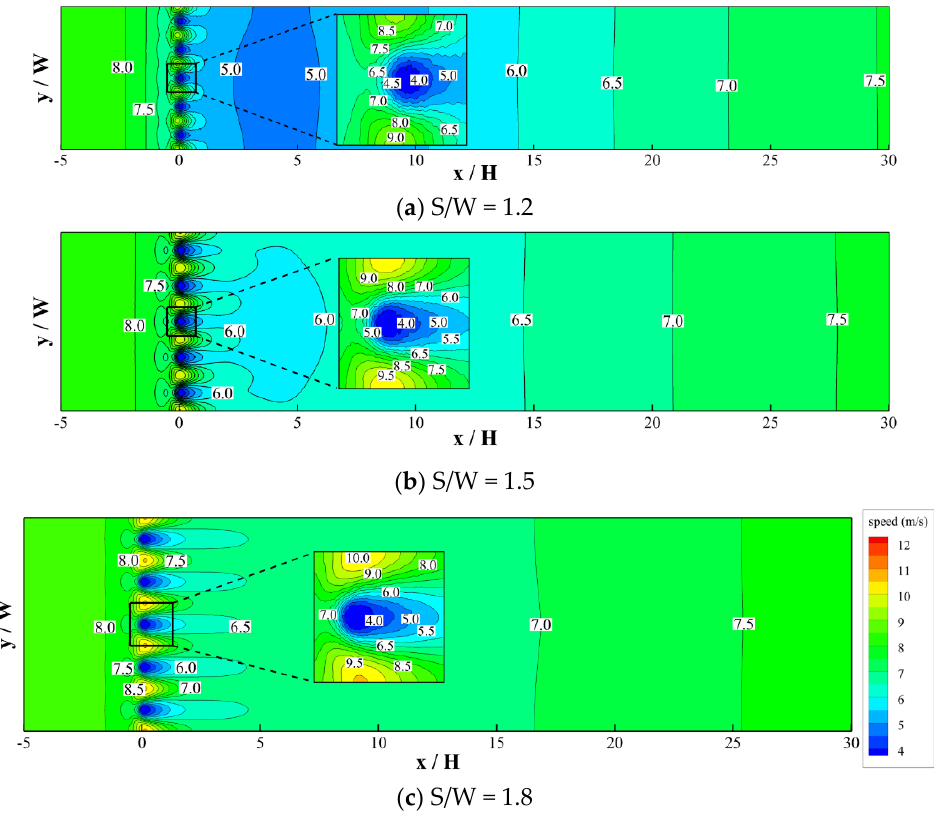
Figure 10. Pedestrian wind speed contours for different tree spaces (H = 6 m).